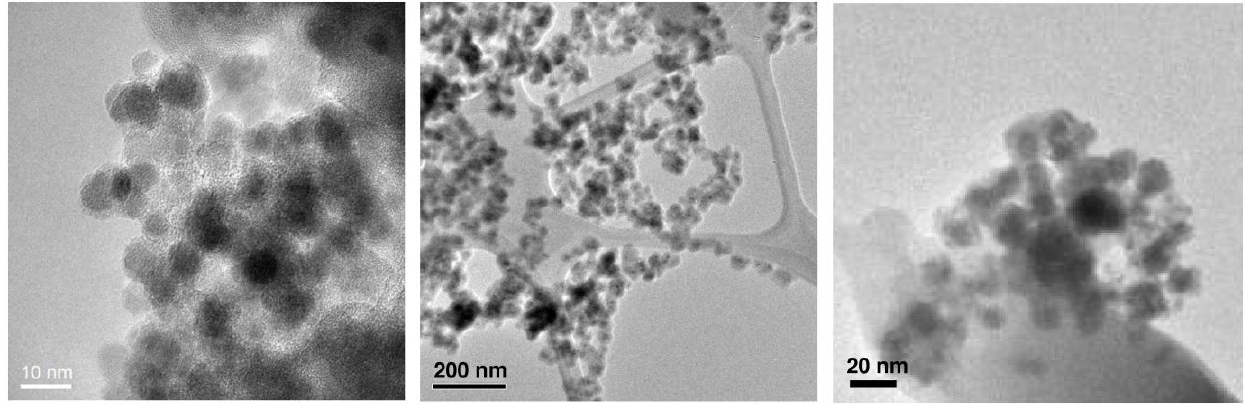
Figure 1. Transmission election microscopic (TEM) images of SPIO@SiO SPIO@dextran (Middle), and SPIO@PEG (Right)